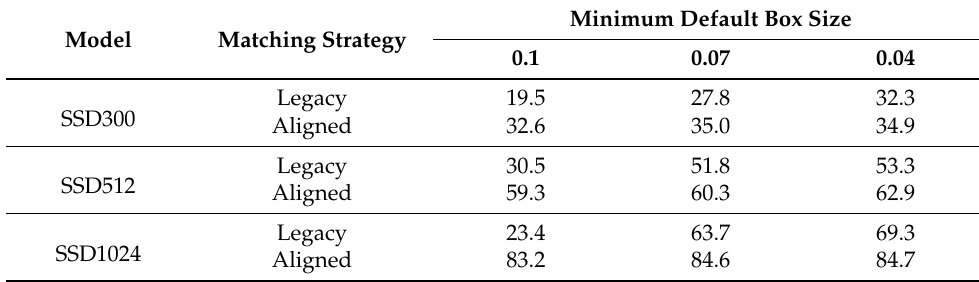
Table 4. SSD’s performance on TT100K with various default box sizes.